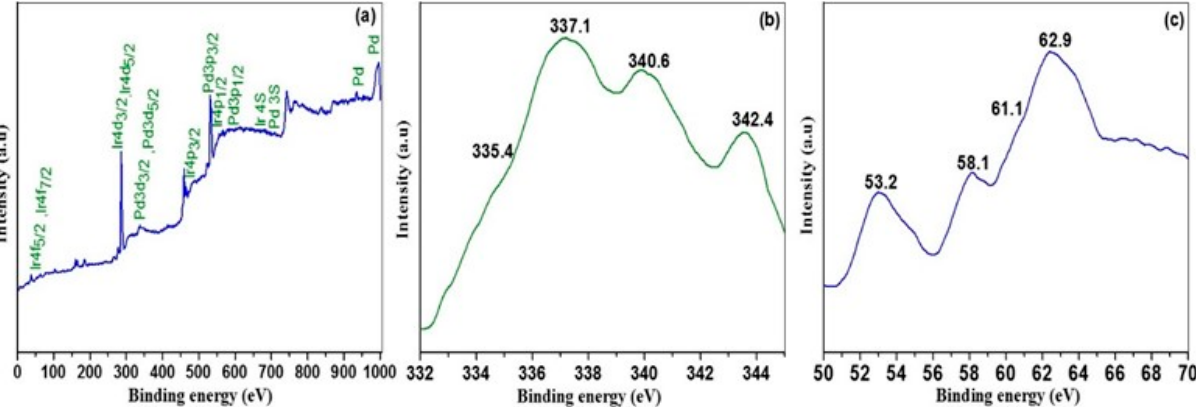
Figure 3. XPS analysis of ( a ) 1% Ir:2% Pd/C, XPS survey spectrum; ( b ) Pd 3d spectrum; and ( c ) Ir 4f spectrum of the same catalyst.